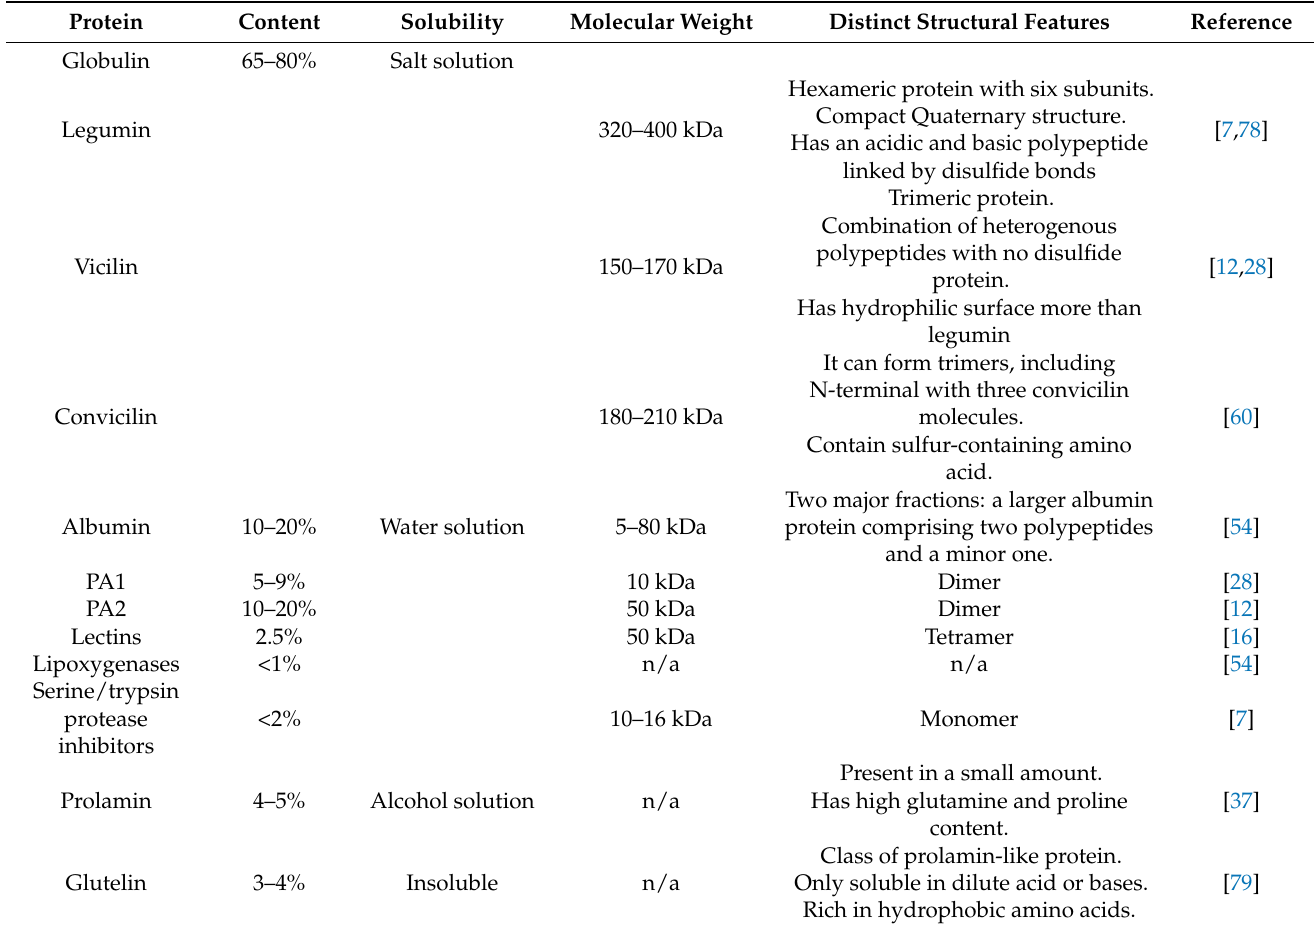
Table 3. Classification of pea protein and its molecular